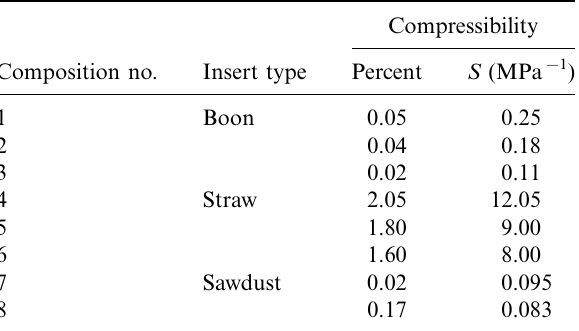
Table 3. Compressibility of composites with components of